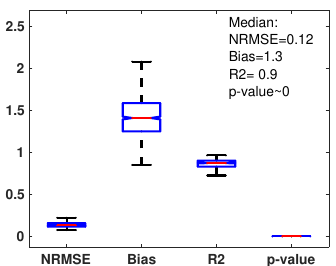
Figure 7. Boxplot of the computed statistical measures of the cross-validation for the computed statistical measures for 1000 iterations of the merged Arctic and COASTlOOC